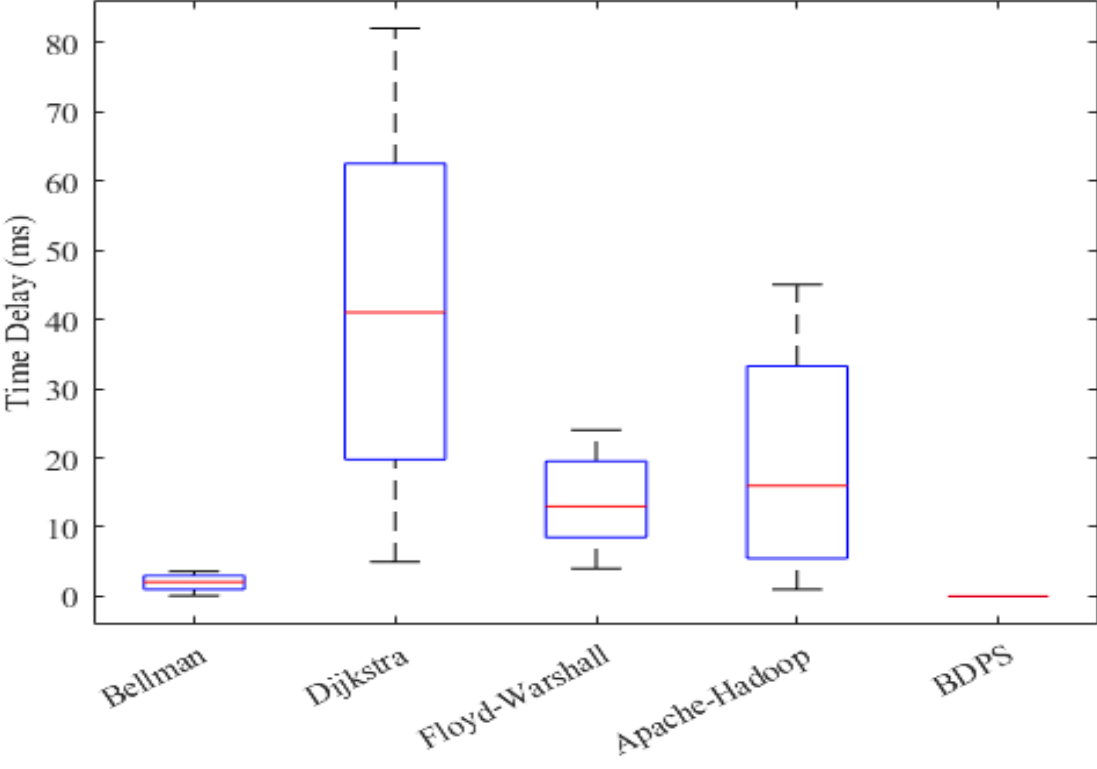
Figure 10. Box plot statistics of time delay among existing algorithms and